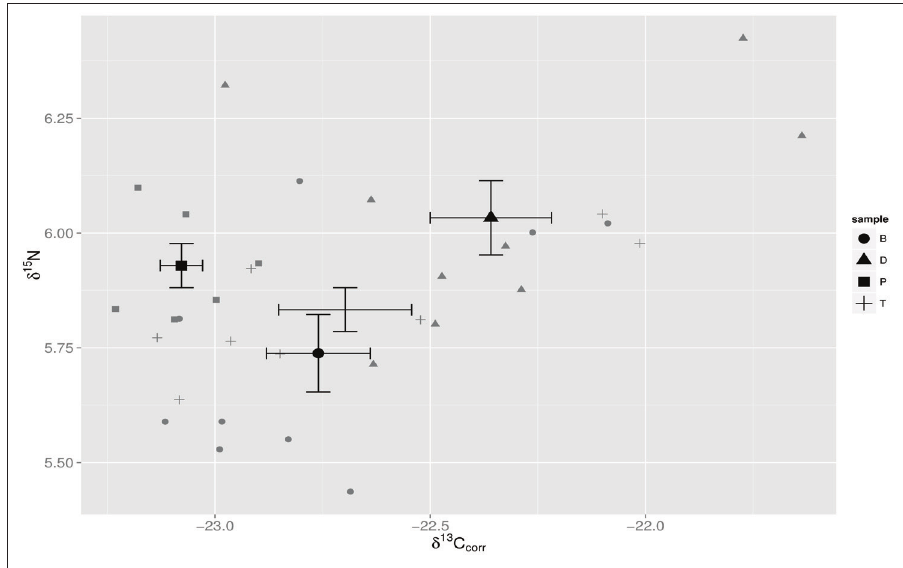
for each sample corr